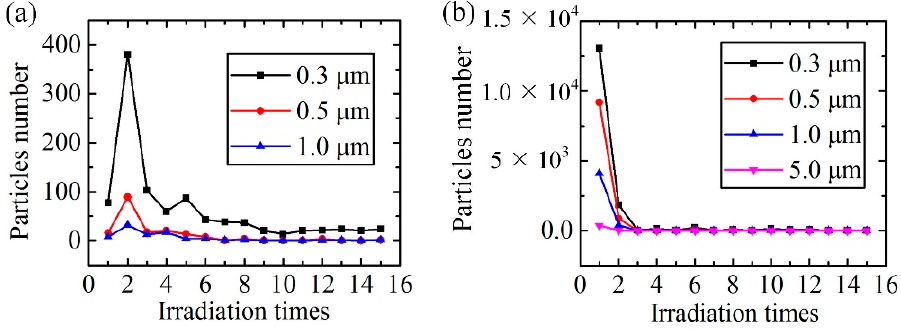
Figure 6. Number and diameters of particles produced by a laser fluence of 0.5 J/cm 2 . ( a ) With functional layers. ( b ) Without functional layers.